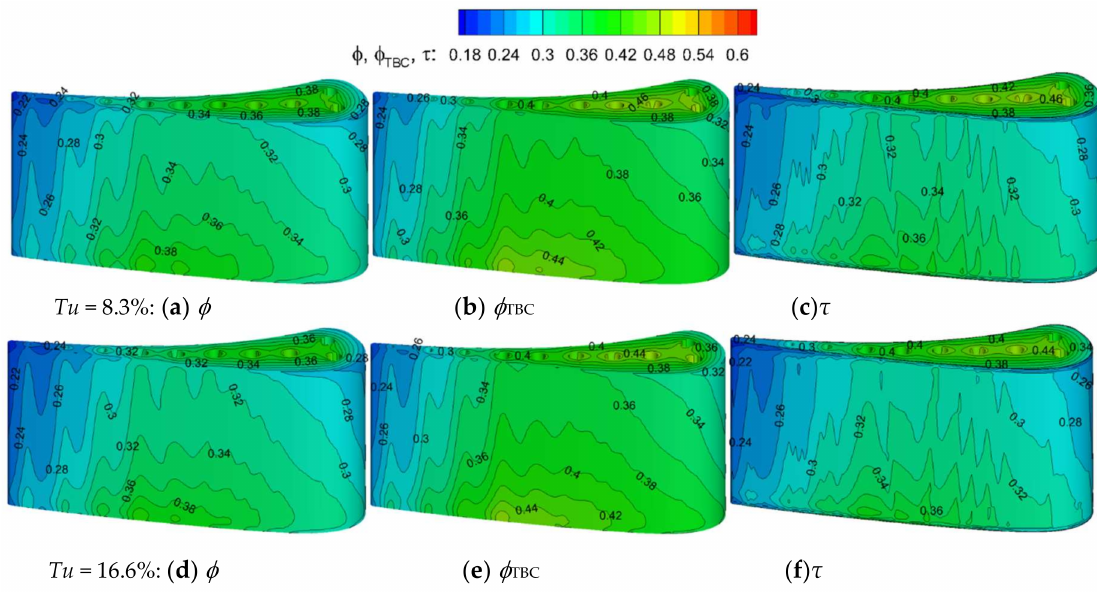
Figure 10. ϕ , ϕ TBC , and τ on the suction side (SS) at Tu = 8.3% and